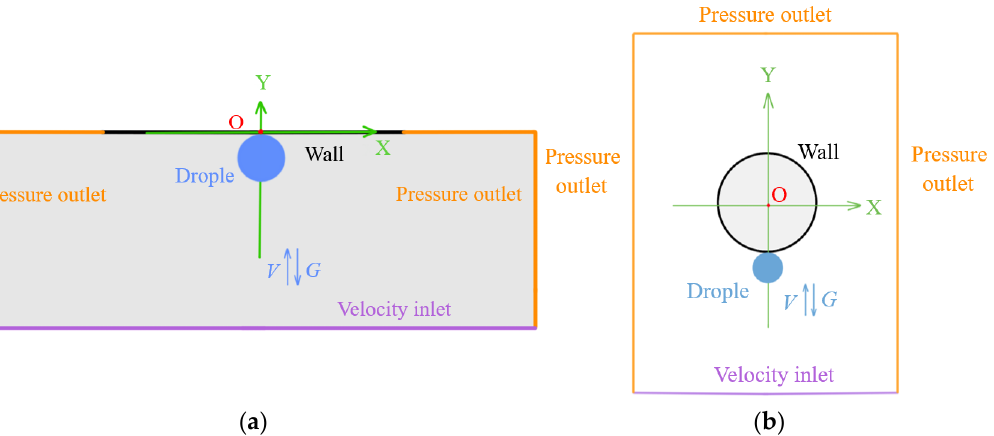
Figure 1. Physical model and boundary conditions of droplet impacting wire: ( a ) flat wire, ( b ) circular wire.